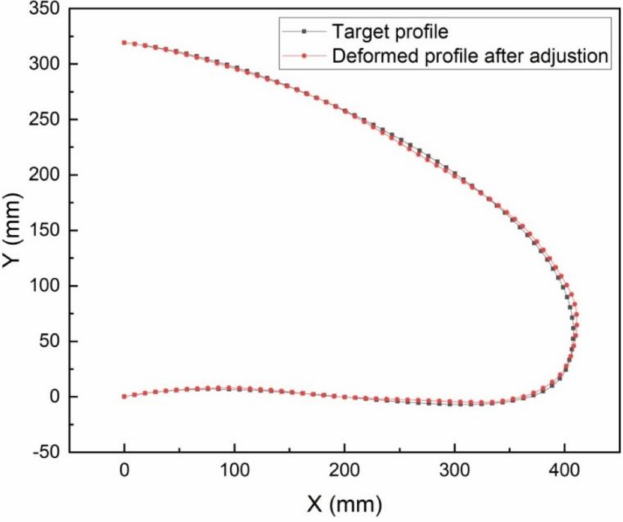
Figure 18. Comparison of profiles between the primitive and adjusted layup in drooped case.